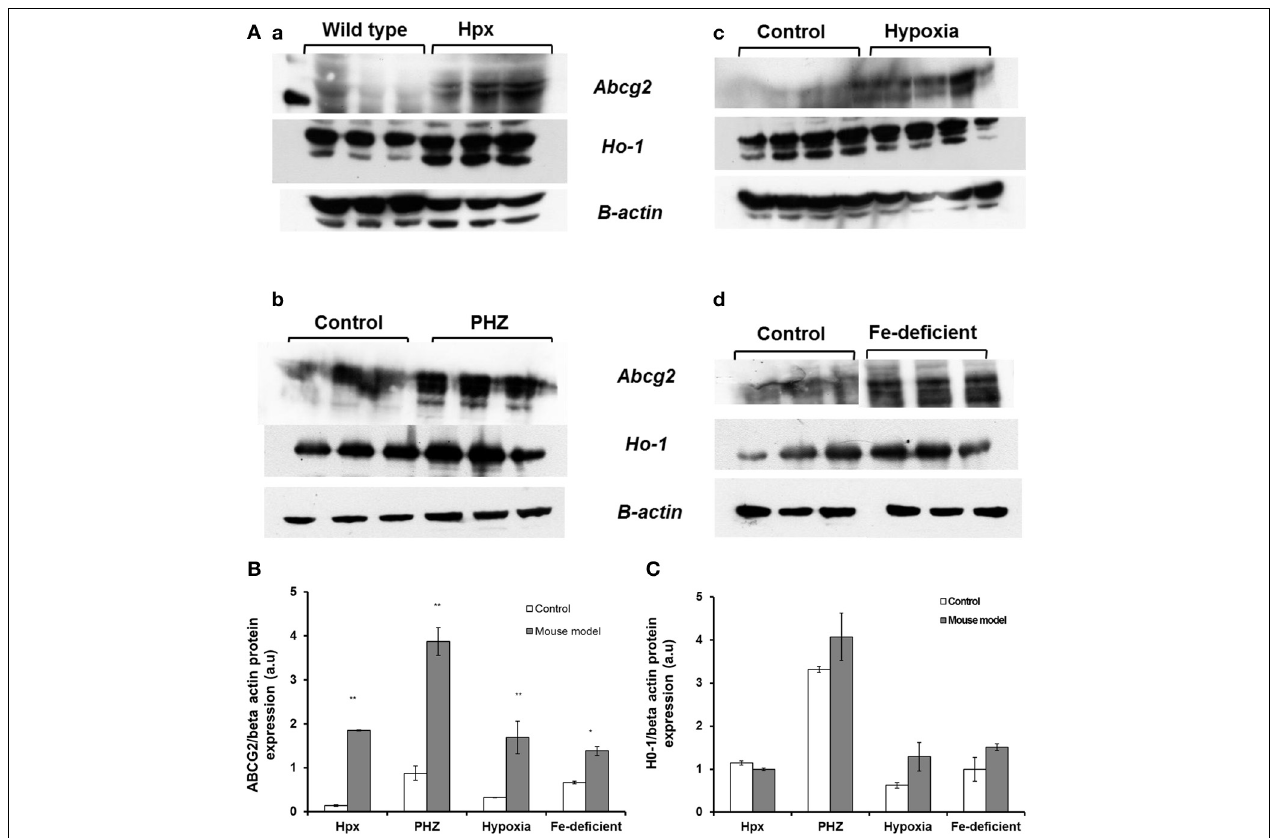
FIGURE 4 | Western blot analysis of Abcg2 protein and Ho1 levels in the spleen samples from Hpx, PHZ-treated, hypoxic and iron-deficient mice. (A) Abcg2 protein levels in mouse spleen samples that were homogenized and subjected to Western blotting as described under methods. (B) Abcg2 protein levels in the spleen tissues. Densitometries of